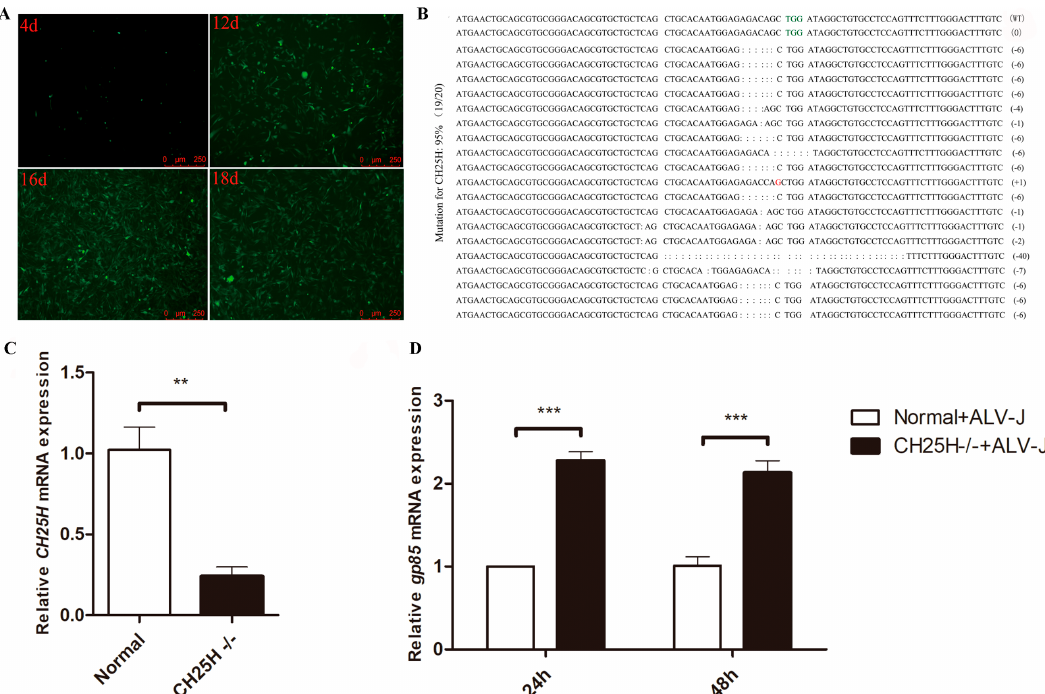
Figure 6. Knockdown of endogenous chCH25H enhanced ALV-J replication. ( A ) The green fluorescence was monitored in chCH25H -knockout cells from 4 to18 days. ( B ) The knockout efficiency of chCH25H in twenty monoclonal bacteria was determined by sequencing. ( C ) The expression level of chCH25H in chCH25H - knockout DF1 cells was detected by qPCR. Compared to normal DF1 cells, the chCH25H expression in chCH25H- knockout cells was significantly decreased. ( D ) qPCR results showed that knockdown of endogenous chCH25H could significantly increased the expression of ALV-J gp85 gene. “CH25H − / − ” represents chCH25H- knockout DF1 cells. “Normal” represents normal DF1 cells. ** p < 0.01; *** p < 0.001.